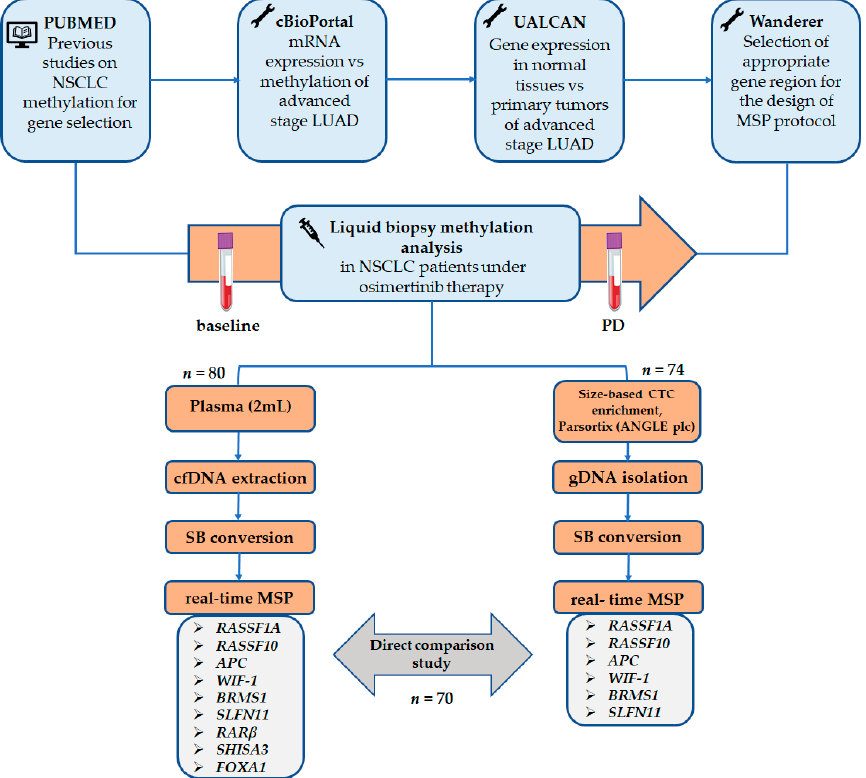
Figure 1. A schematic flowchart of the study (NSCLC: non ‐ small cell lung cancer, LUAD: lung adenocarcinoma, MSP: methylation specific PCR, CTC: circulating tumor cells, SB: sodium bisulfite).